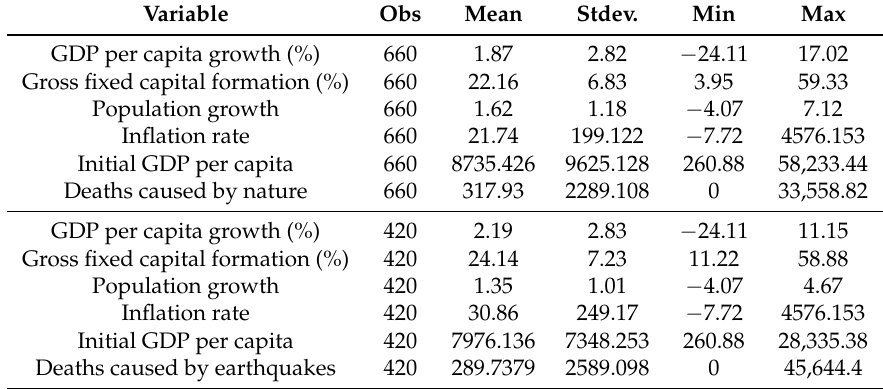
Table 1. Summary